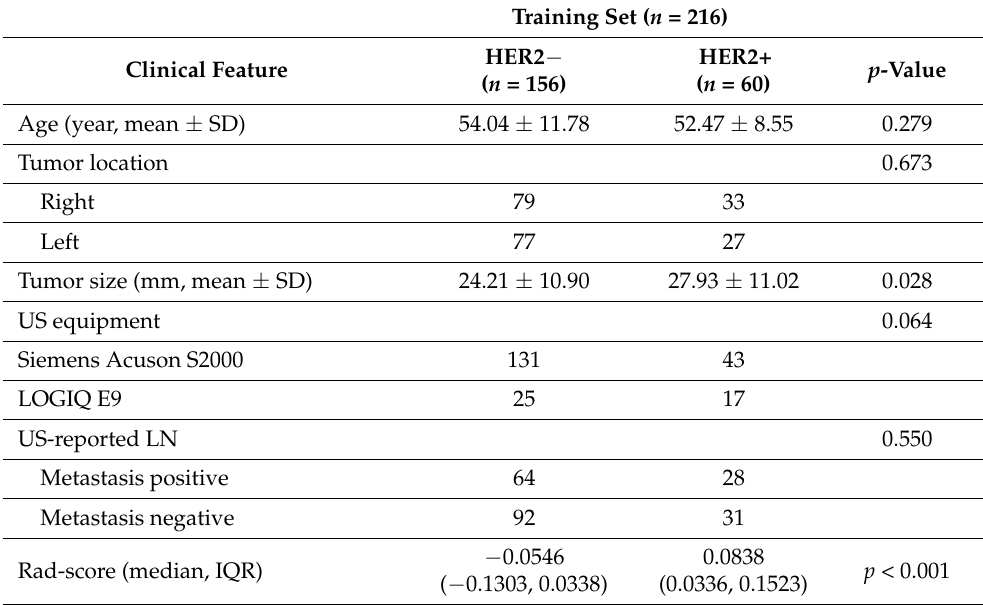
Table 6. Comparison of the clinical features between the HER2+ and HER2 − BC groups in the training